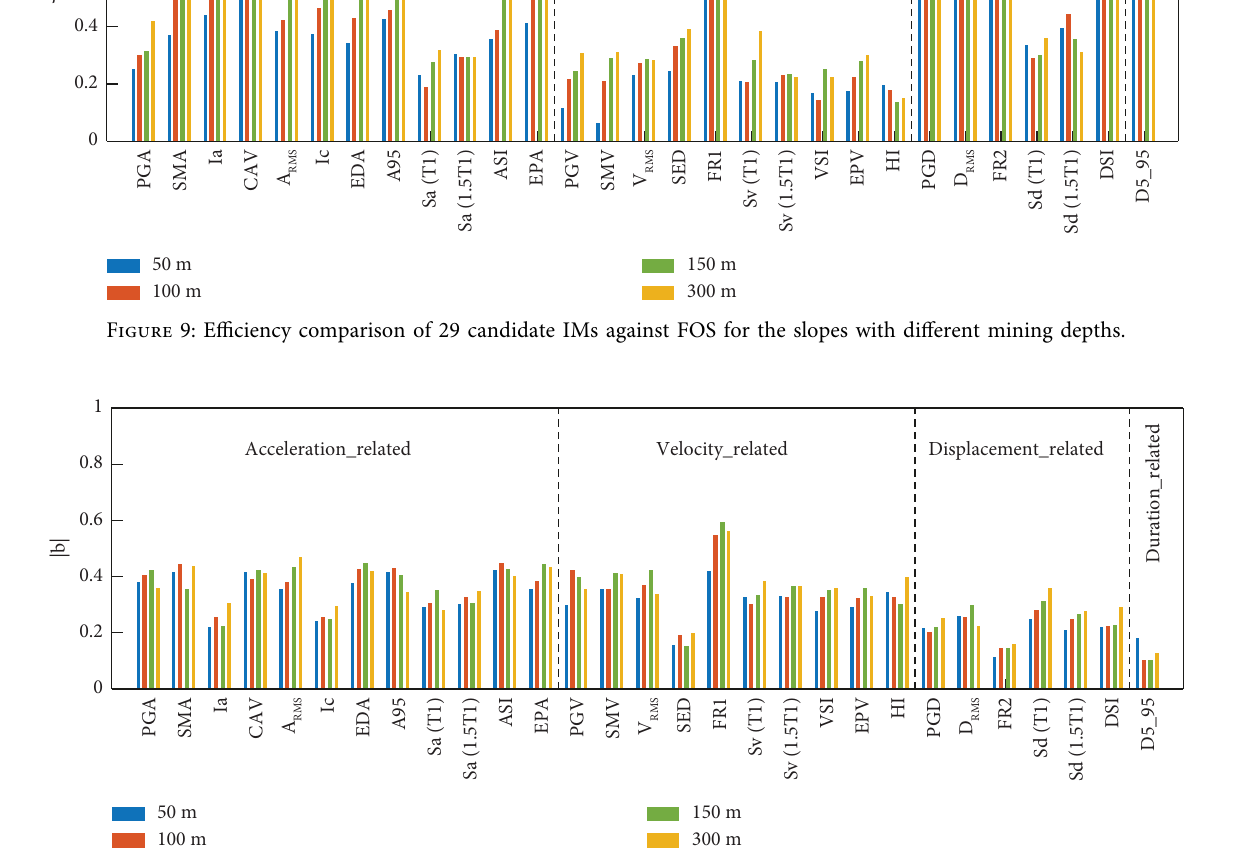
Figure 10: Practicality comparison of 29 candidate IMs against FOS for the slopes with diferent mining depths.